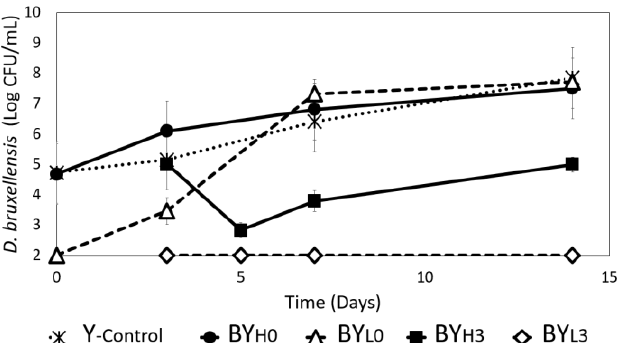
Figure 2. D. bruxellensis growth during 14 days cultivation in mono (Y -control ) and co-cultures with K. intermedius at 30 ◦ C. D. bruxellensis was added simultaneously at concentrations of 10 6 CFU/mL (BY H0 ) and 10 3 CFU/mL (BY L0 ) and sequentially at 10 6 CFU/mL (BY H3 ) and 10 3 CFU/mL (BY L3 ).